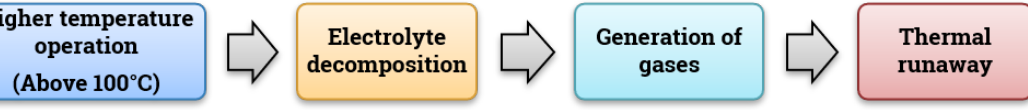
Figure 6. Electrolyte failure mechanism.